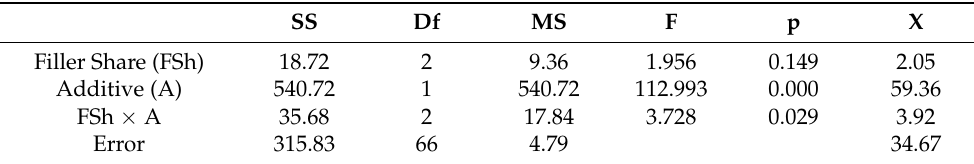
Table 7. Analysis of variance for selected factors and interactions between the factors influencing the axial force during drilling HDPE-based composite with addition of MAHPE.